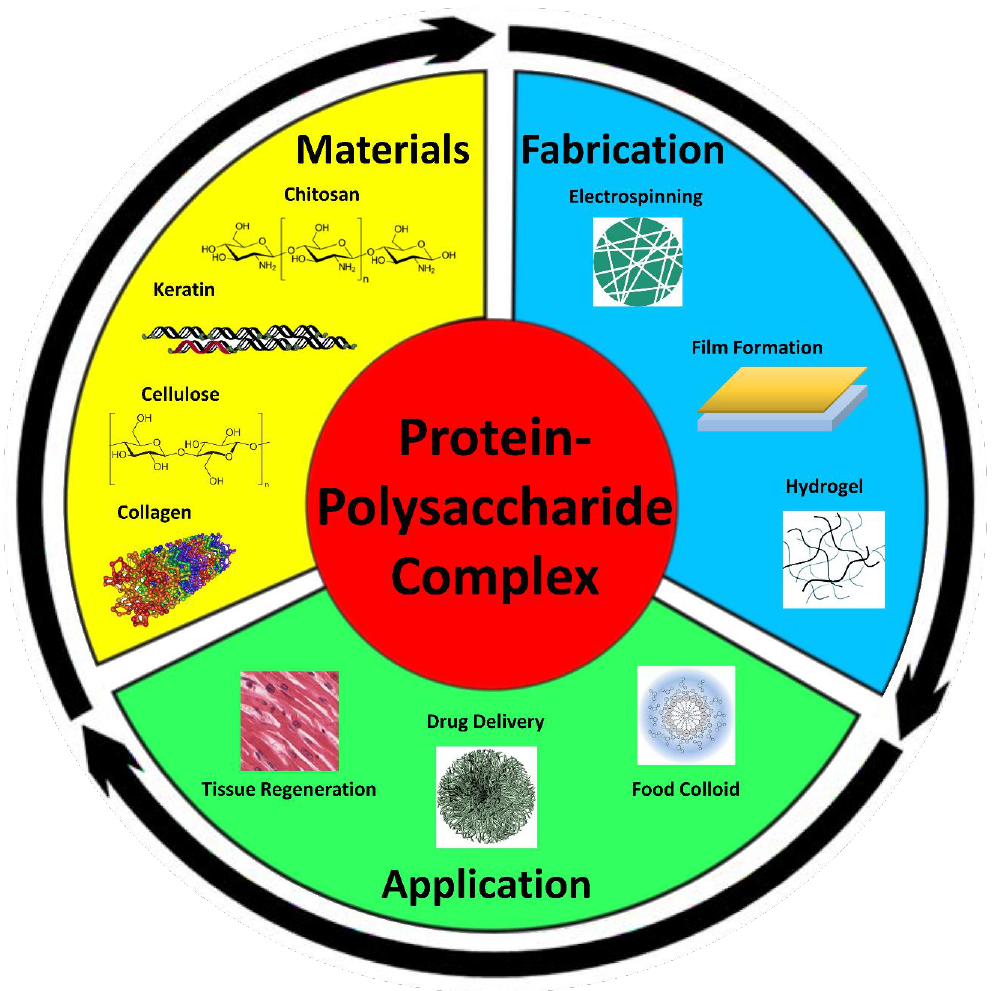
Figure 1. Protein–polysaccharide composite materials can be fabricated from a variety of protein and polysaccharide sources. These complex materials can then be processed into variable shapes with unique properties for a multitude of applications.